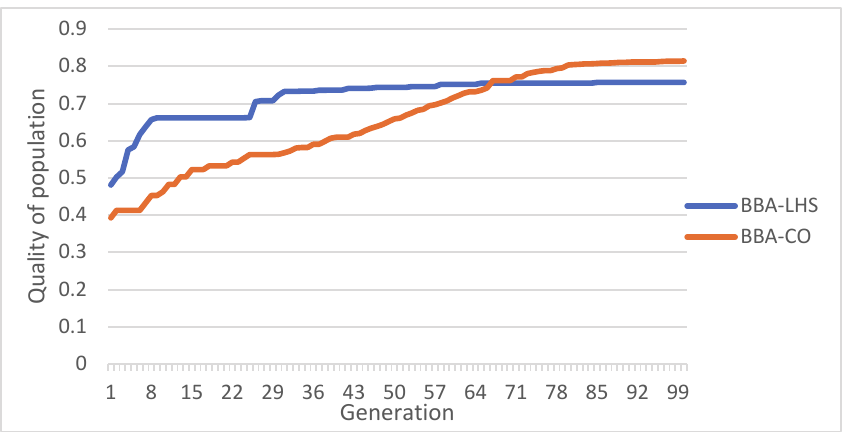
Figure 8. Convergence behavior of the population using BBA LHS and BBA CO for Reuters dataset.